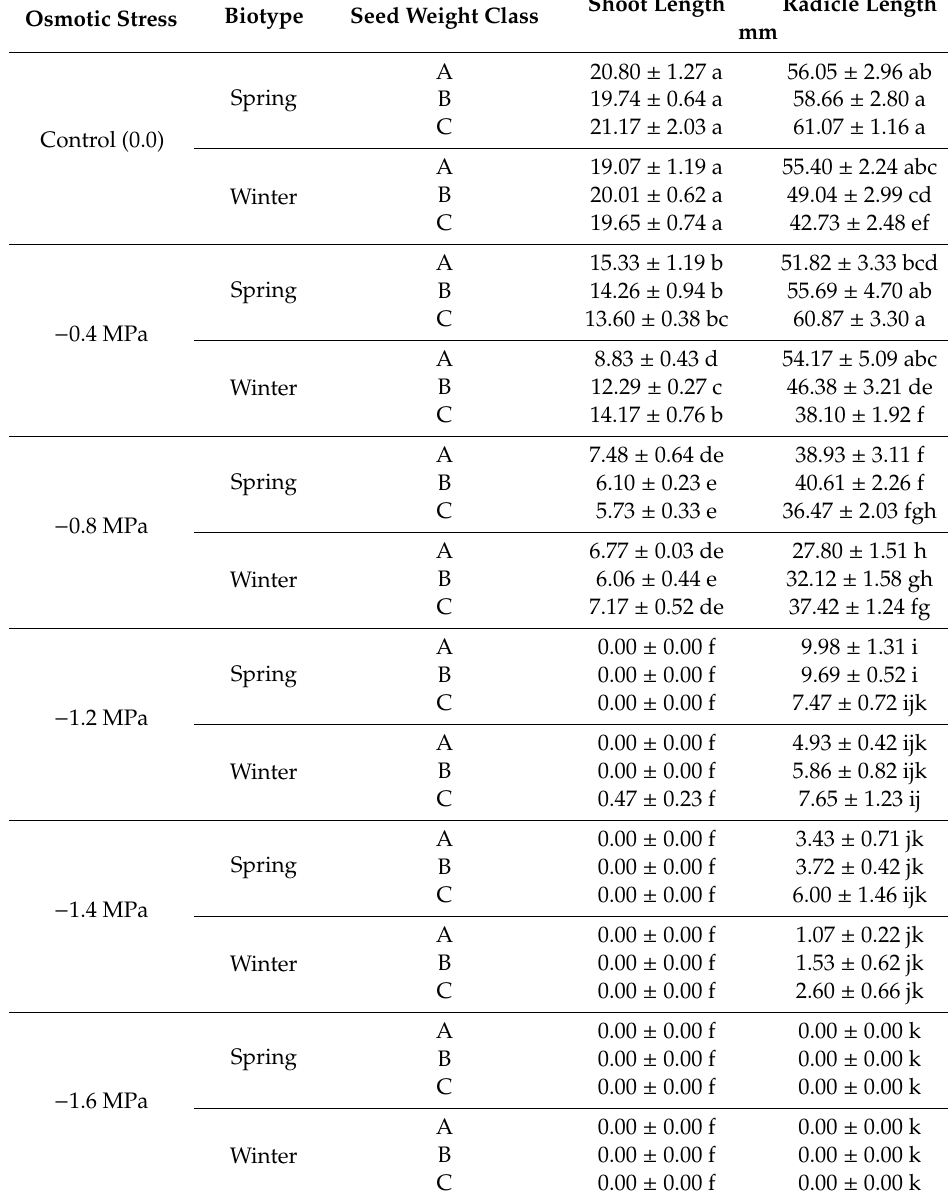
Table 5. Shoot and radicle lengths of camelina as a ff ected by the interaction osmotic stress level (0 vs. − 0.4 vs. − 0.8 vs. − 1.2 vs. − 1.4 vs. − 1.6 MPa) × biotype (winter vs. spring) × seed weight